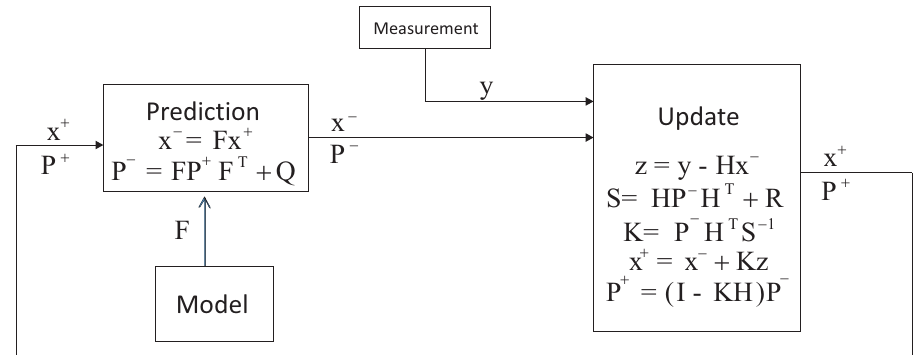
Figure 3. Block diagram of the Kalman filter.